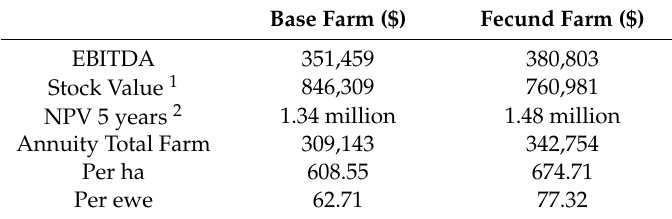
Table 4. Financial summary of the farm-level case (Base farm) and farm-level case (Fecund farm). Base Farm